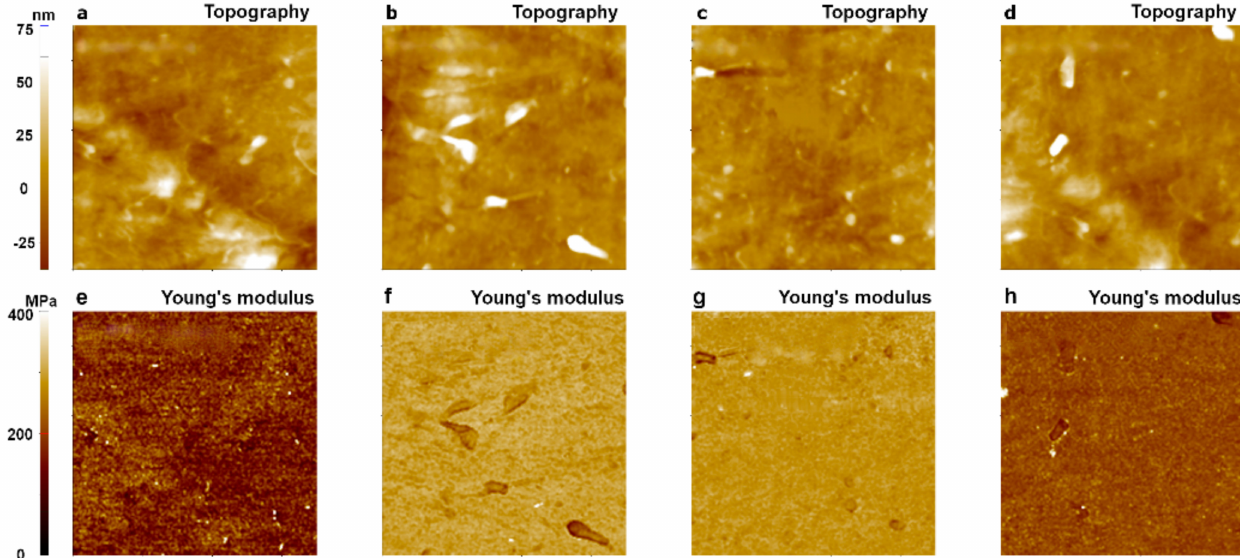
Figure 10. Topography and Young’s modulus images of LDPE obtained with a PPP-FMR cantilever (tip radius: 10 nm) using the PinPoint TM nanomechanical mode of AFM. The 1st image ( a , e ); 10th image ( b , f ); 100th image ( c , g ); and 200th image ( d , h ). The size of all images was 10 µ m × 10 µ